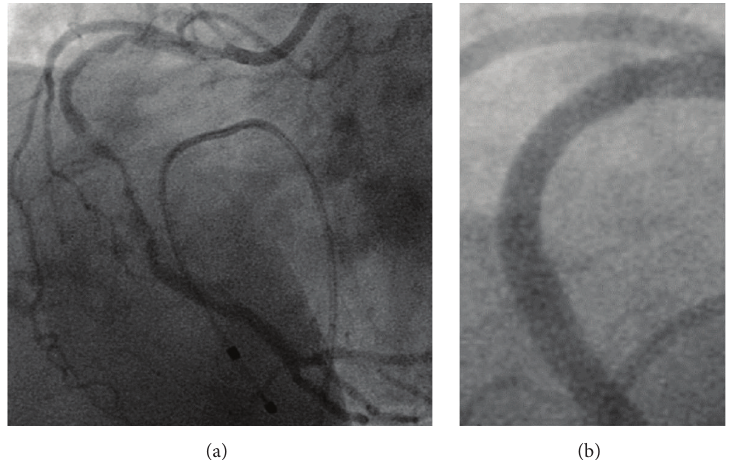
Figure 1: First percutaneous coronary intervention (PCI#1). (a) Baseline coronary angiography (CAG). (b) CAG after first stenting.